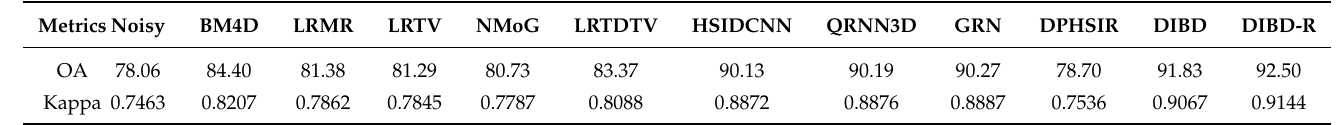
Table 7. Classification quantitative result on Indian Pines dataset. DIBD-R denotes DIBD training on paired and unlabeled mixed